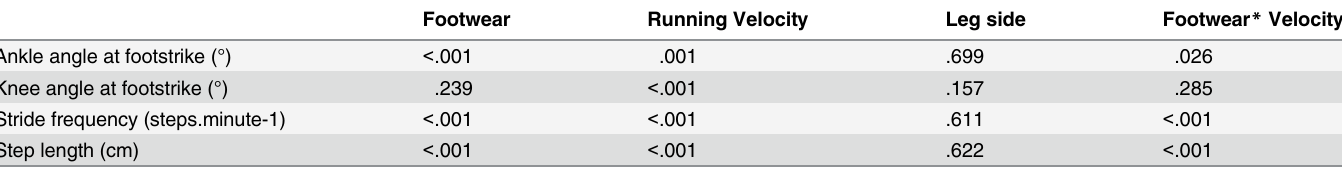
Table 2. Mixed model effects (p-values) for included